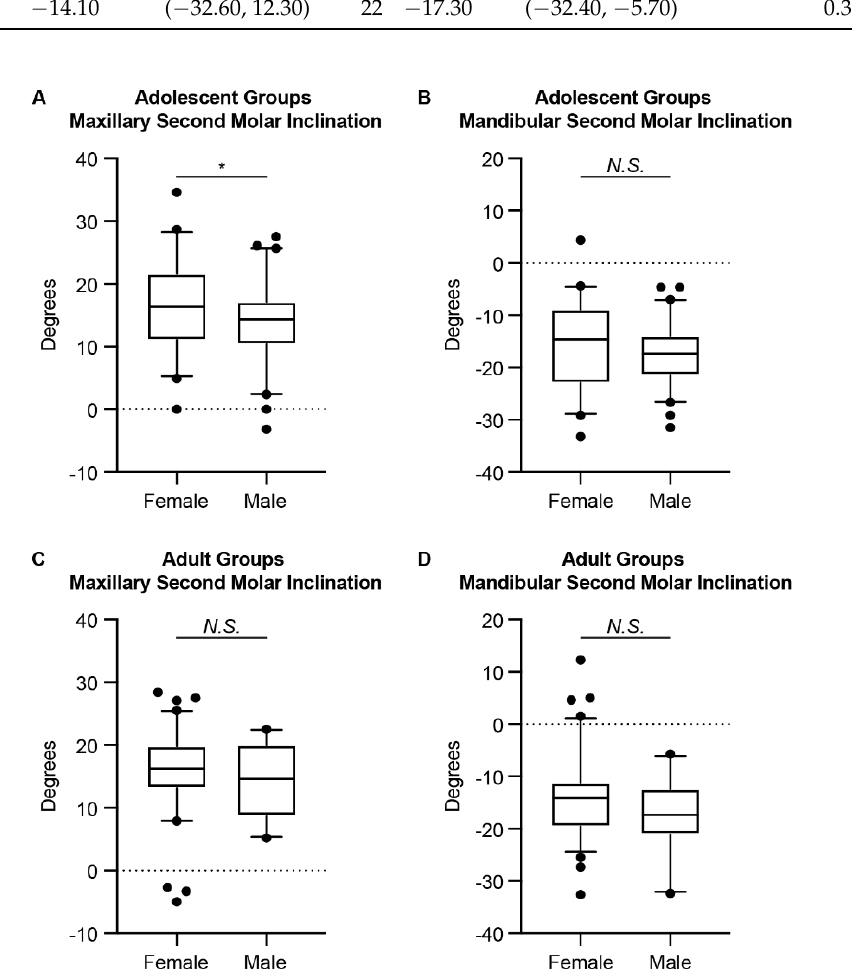
Figure 3. The comparison of the second molar inclination between genders. The ( A ) maxillary and ( B ) mandibular second molar inclination of females and males in the adolescent groups. The ( C ) maxillary and ( D ) mandibular second molar inclination of females and males in the adolescent groups. The Mann–Whitney U test was used. The box plot represents the 5th percentile, 25th percentile, median (50th percentile), 75th percentile, and 95th percentile, respectively. *: p < 0.05; N.S.: not significant.